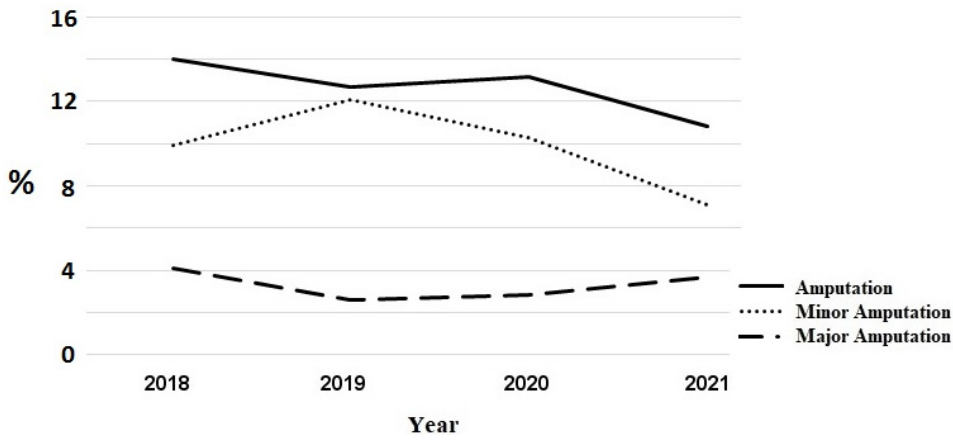
Figure 2. Title: Proportionate course of in-house amputations in patients with Rutherford–Becker class 5 (including minor and major). Legend: Proportionate major and minor in-house amputations in patients with Rutherford–Becker class 5.